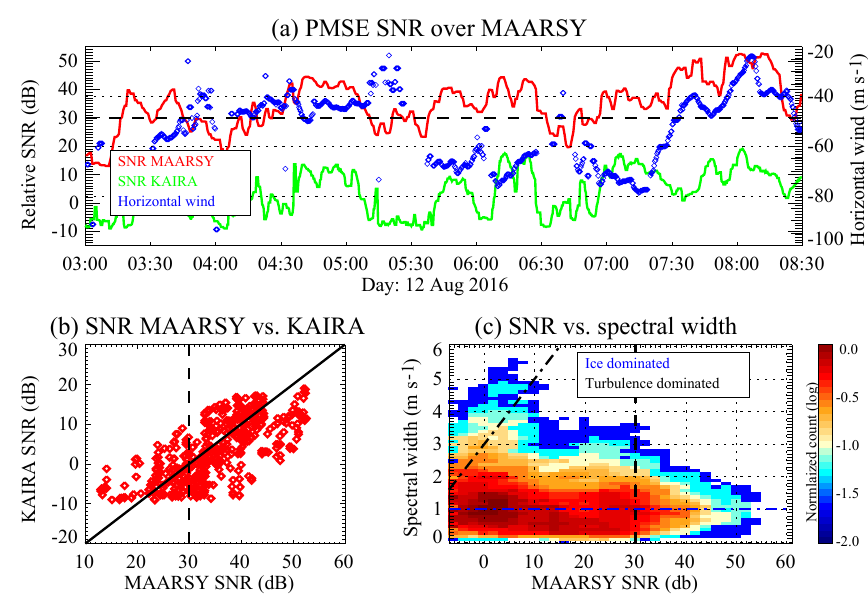
Figure 6. Combined MAARSY and KAIRA measurements: (a) median SNR over MAARSY as observed with MAARSY and KAIRA, and over the middle point; (b) MAARSY vs. KAIRA SNR scatter plot; and (c) bivariate distribution of MAARSY SNR vs. spectral width. The dashed lines indicate MAARSY’s 30dB SNR as a reference. In panel (a) , the mean horizontal wind over MAARSY in the direction MAARSY–KAIRA is shown in